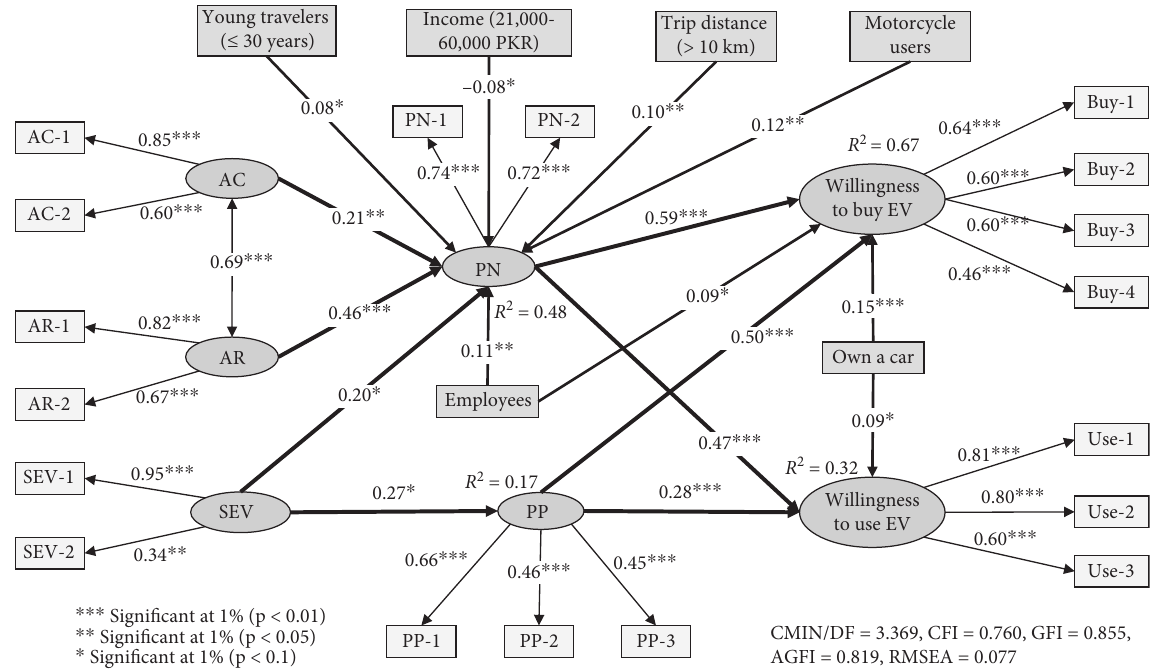
Figure 2: Structural model of travelers’ willingness to buy and use an electric vehicle (AC: awareness of consequences, AR: ascription of responsibility, PN: personal norm, SEV: social and economic value, PP: personal preferences, CMIN/DF: chi-square/degree of freedom, CFI: comparative fit index, GFI: goodness of fit index, AGFI: adjusted goodness of fit index, and RMSEA: root mean square error of